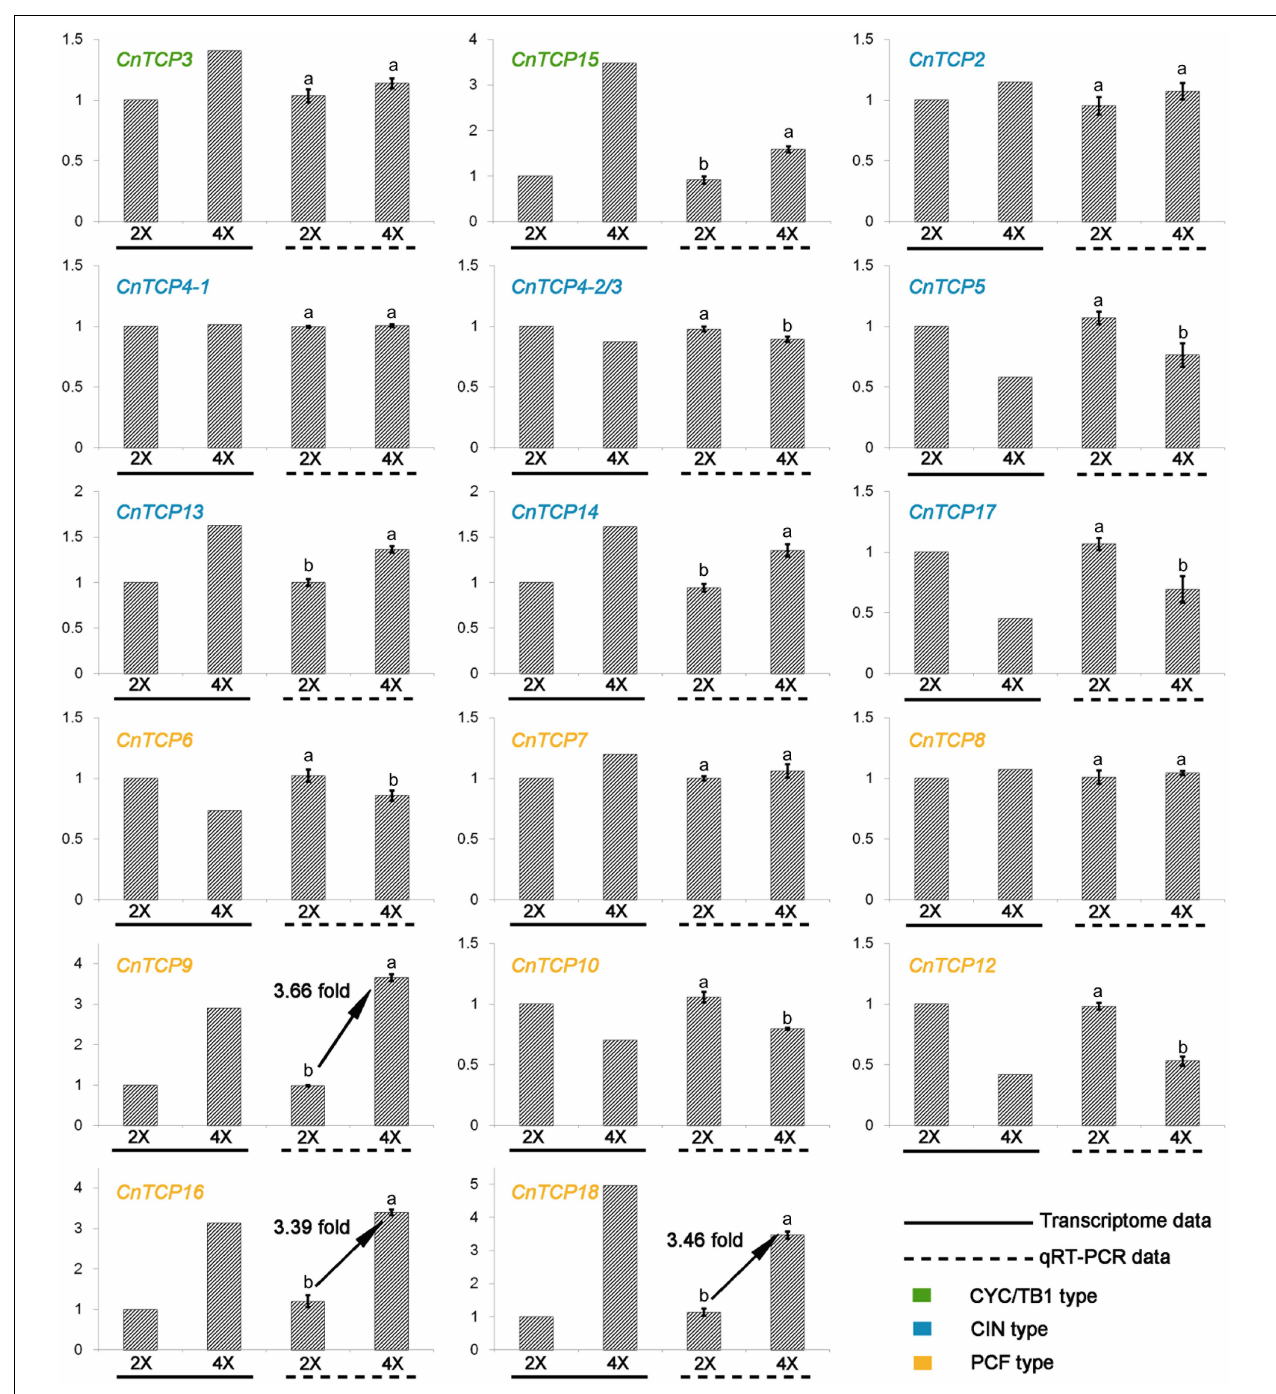
compared using the foldchange value of tetraploidy/diploidy, if it was red, it means the gene was up-regulated in the tetraploidy compared to the diploidy, if it was blue, it means down-regulated. Meanwhile, all differentially expressed genes